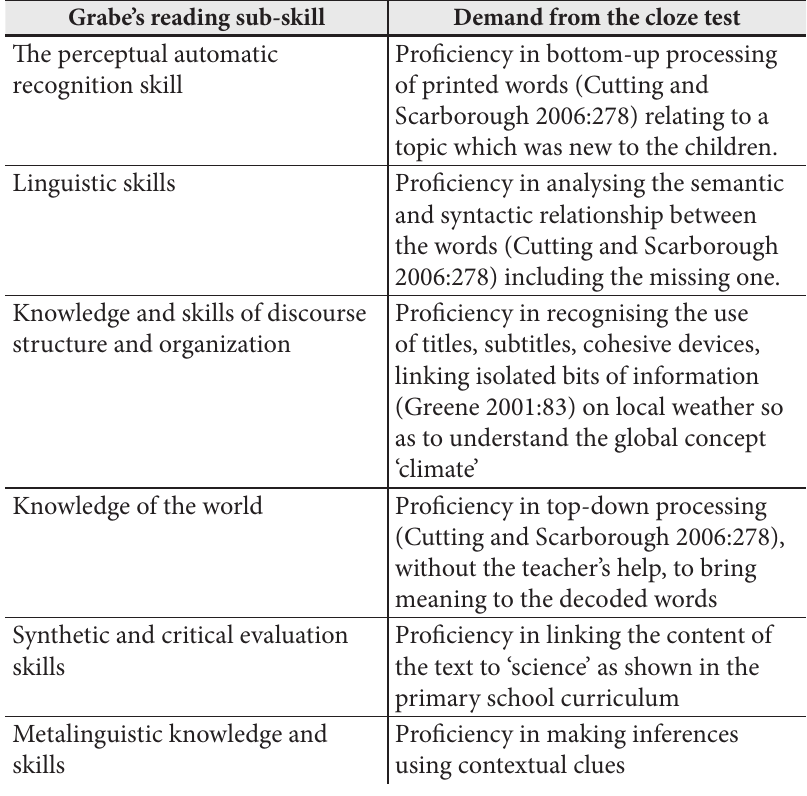
Table 2: The demands on the children’s reading skills Grabe’s reading sub-skill